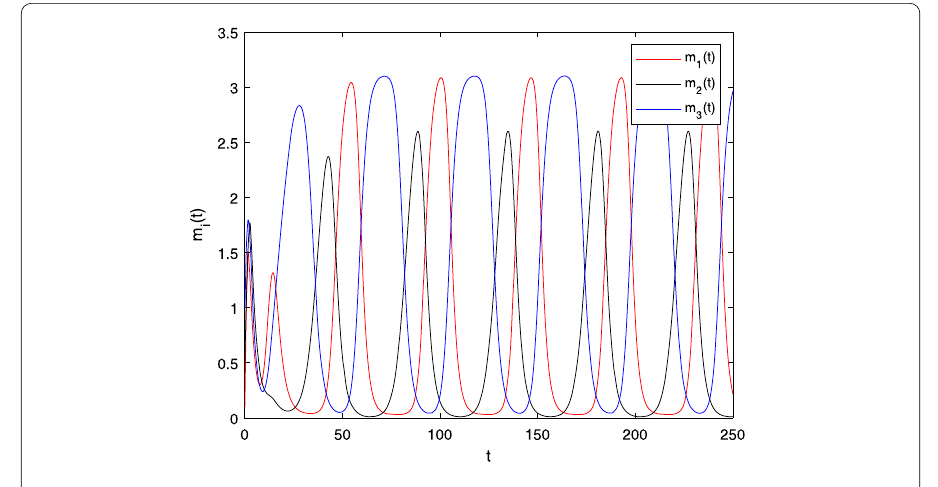
Figure 5 Time response of mRNAs m i ( t ), i = 1,2,3